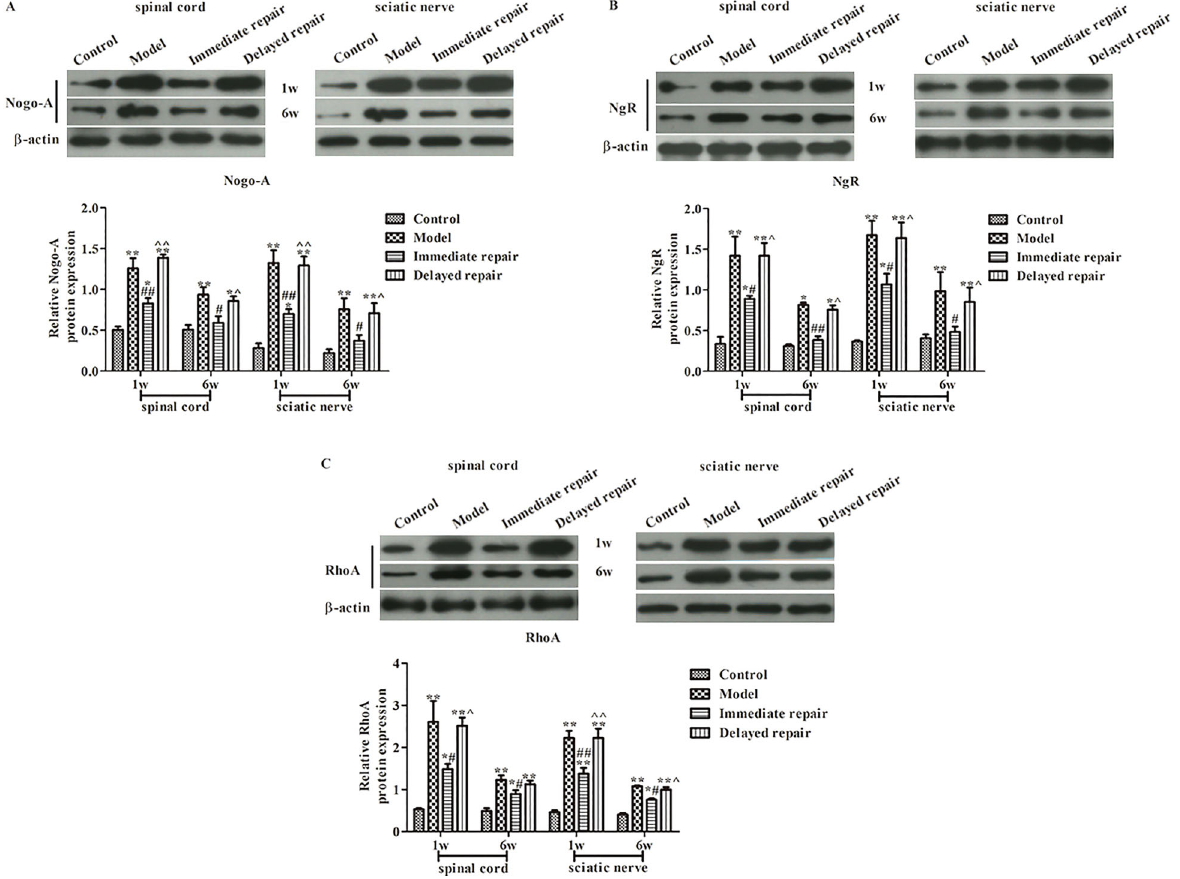
Figure 4. The expression of Nogo-A ( A ), NgR ( B ), and RhoA ( C ) protein was detected by western blot in rats after sciatic nerve injury. *P o 0.05, **P o 0.01 compared with control group; # P o 0.05, ## P o 0.01 compared with model group; ^ P o 0.05, ^^ P o 0.01 compared with Immediate repair group. The data are reported as means ± SD and were compared with ANOVA followed by LSD